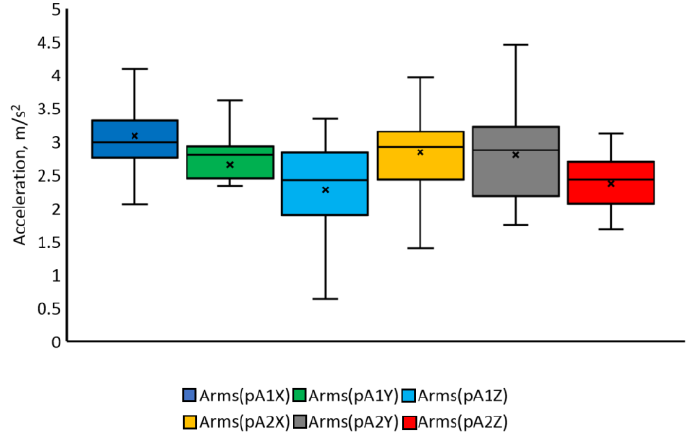
Figure 14. Summary of rms acceleration values obtained in the study of reaching movements in the acceleration phase.